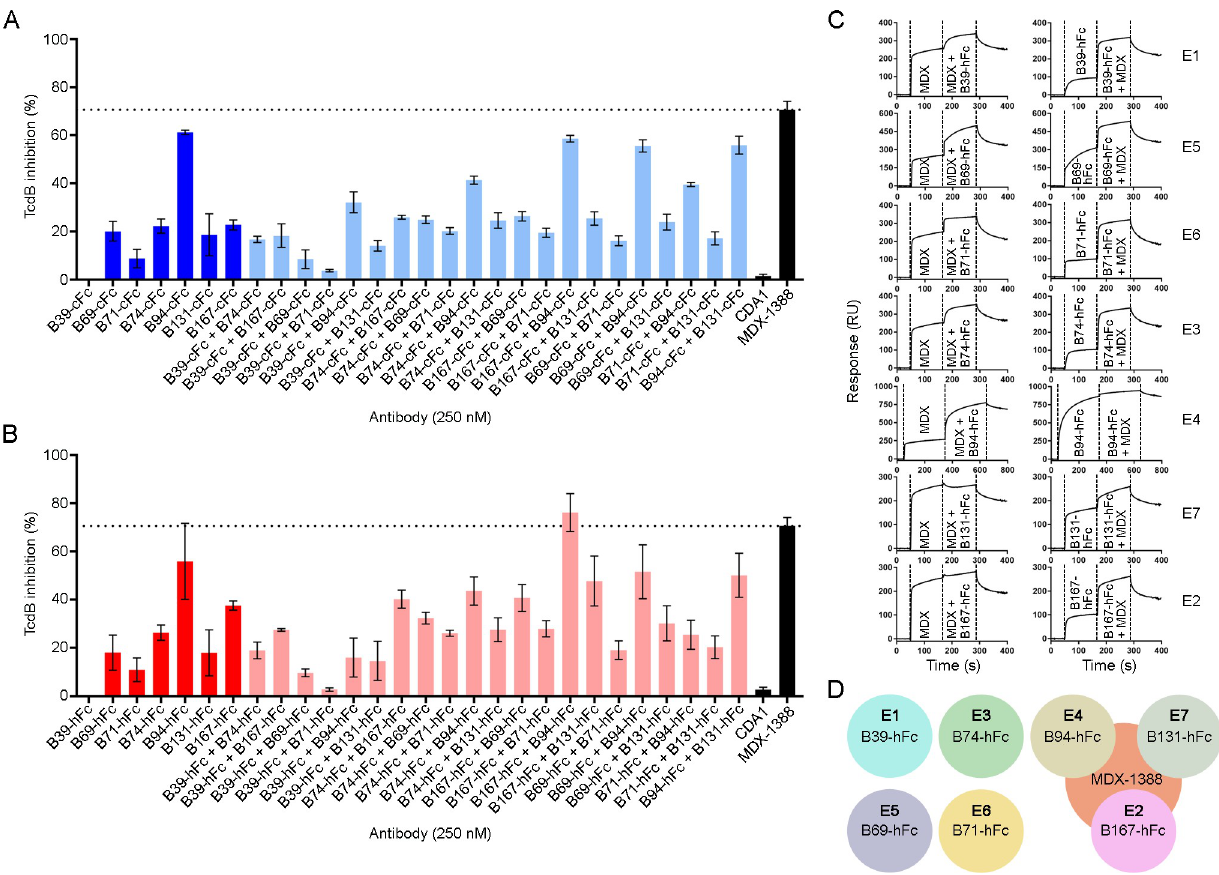
Fig 5. TcdB neutralization assays with V H H-Fcs. (A) TcdB neutralization with V H H-Fcs containing a camelid hinge. (B) TcdB neutralization with V H H-Fcs containing a human hinge. In (A) and (B), the final TcdB concentration of 500 fM and final antibody concentration of 250 nM (single antibody) or 125 + 125 nM (pairs) were co-incubated with Vero cell monolayers for 72 h before addition of WST-1 cytotoxicity reagent. Neutralization values are presented as mean ± SD from n = 4 independent experiments. (C) Sensorgrams showing SPR-based epitope binning of MDX-1388 mAb with each V H H- hFc, in both orientations, with antibodies injected at 25–50 × K D concentrations over TcdB 1751-2366 surfaces. Epitope bins corresponding to each V H H- hFc are noted. (D) Summary of V H H-Fc reactivity to TcdB 1751-2366 illustrating that several V H H-Fcs bind TcdB at sites distinct from MDX-1388, while others bind TcdB at regions that partially overlap with MDX-1388.